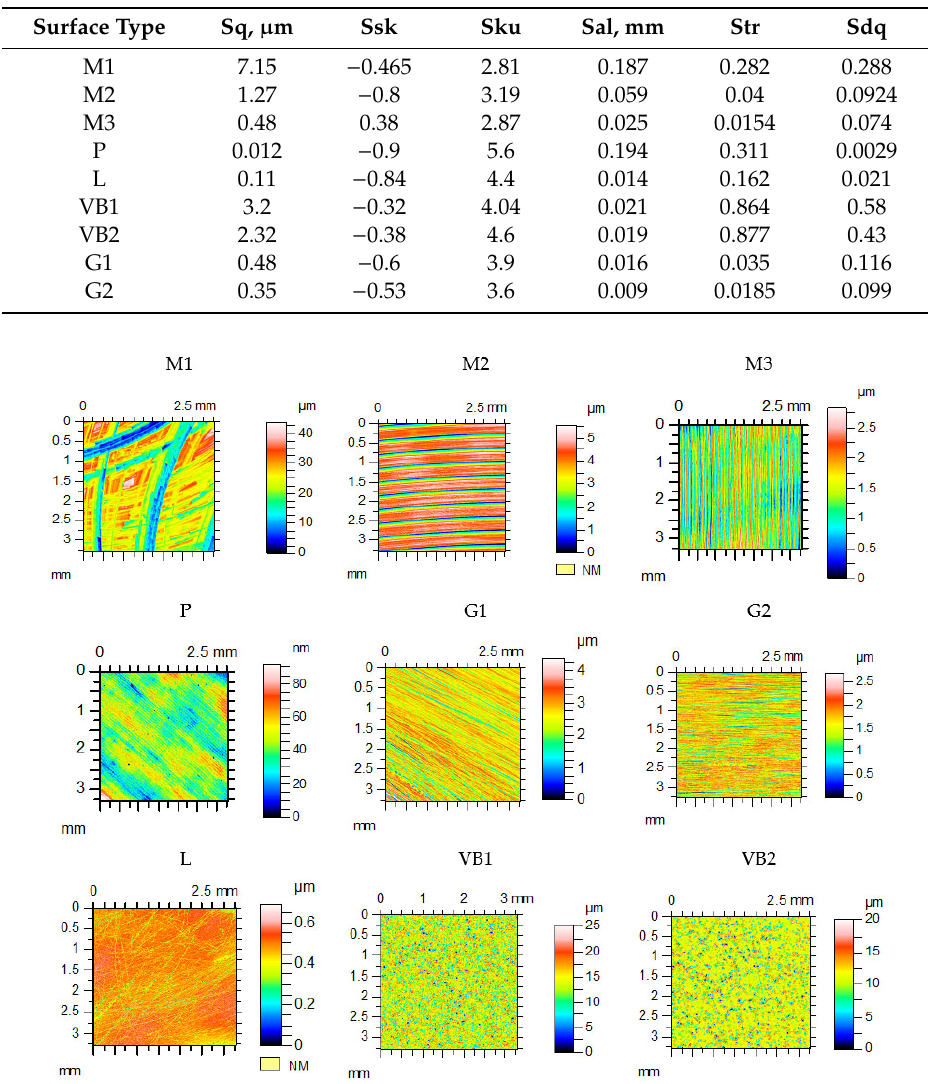
Figure 2. Contour plots of disc